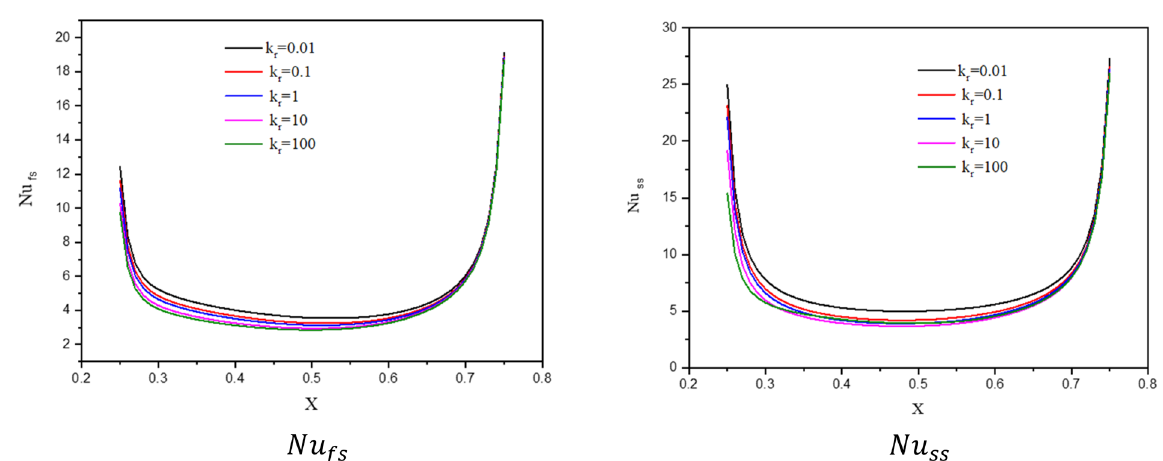
Figure 17. Profiles of Nu fs and Nu ss along a heat source below the changes on a modified conductivity ratio k r for a hybrid nanofluid at φ Cu = φ TiO 2 = φ/ 2, φ = 0.05, B = 0.5, Q = 1, R d = 0.5, Da = 10 − 3 , ε = 0.5, k fs = 1, D = 0.5, H ∗ = 10, Ha =